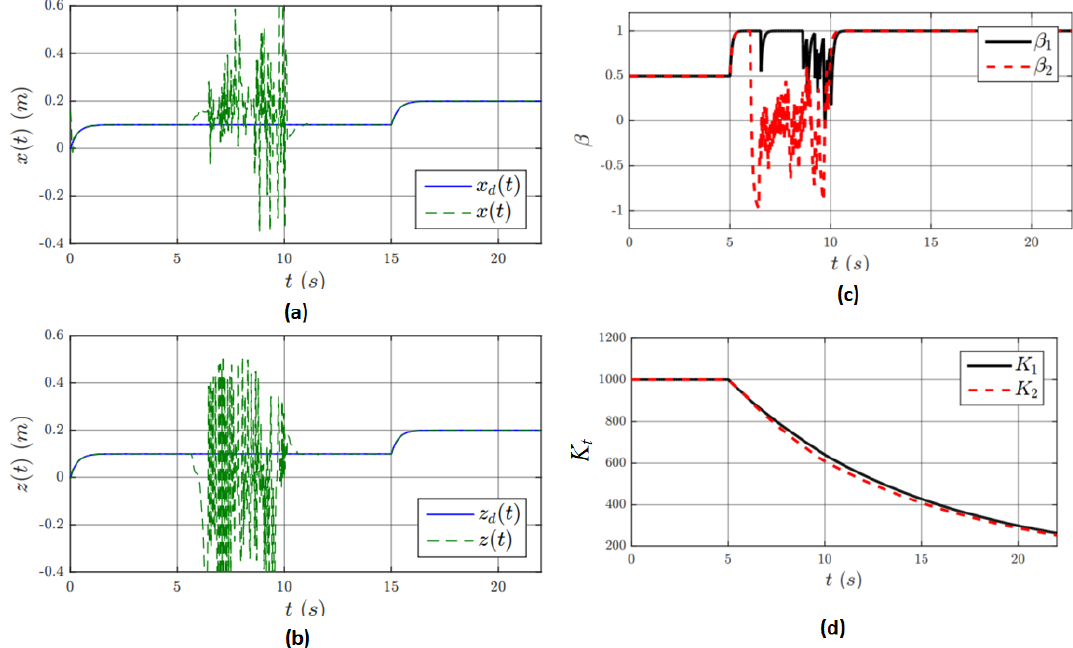
Figure 11. Cartesian position x and z for the multi-step response. (c) The evolution of β for the multi-step case. (d) The evolution of K t for the multi-step case.